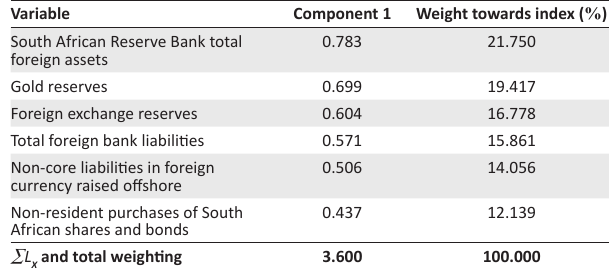
TABLE 8: Component loadings of South African foreign financial